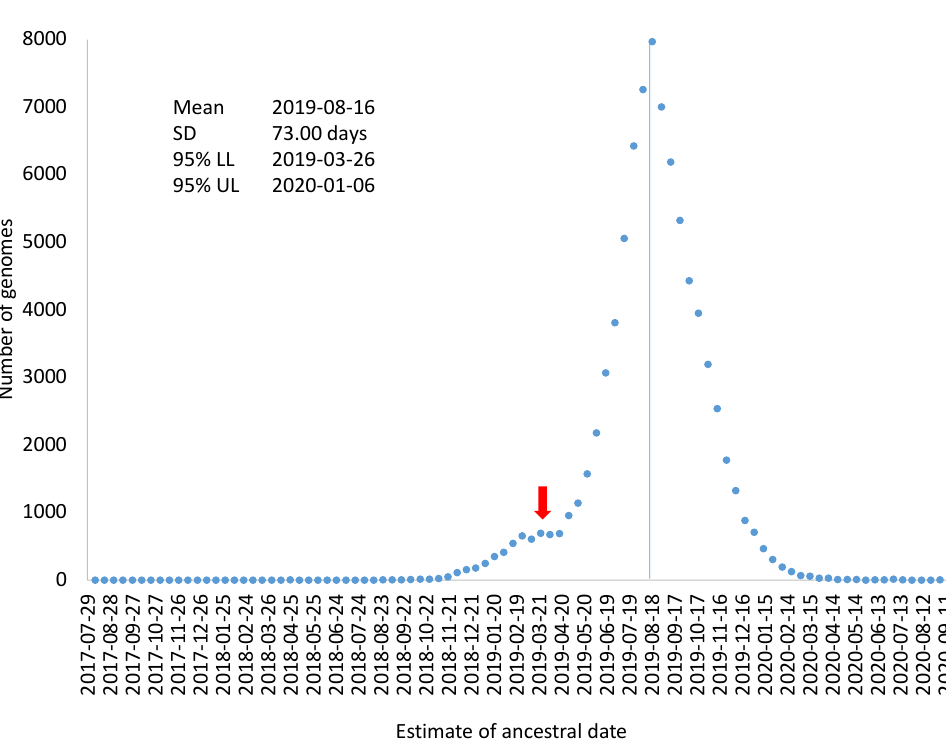
Figure 3. Frequency distribution of T Ai (=T i − D i / µ ) for characterizing variation in T A (the time for the origin of the common ancestor of the sampled SARS-CoV-2 genomes). The mean, standard deviation (SD), and 95% confidence interval are shown. The red arrow indicates the possible existence of another distribution, i.e., the distribution might be a mixture of two distributions.